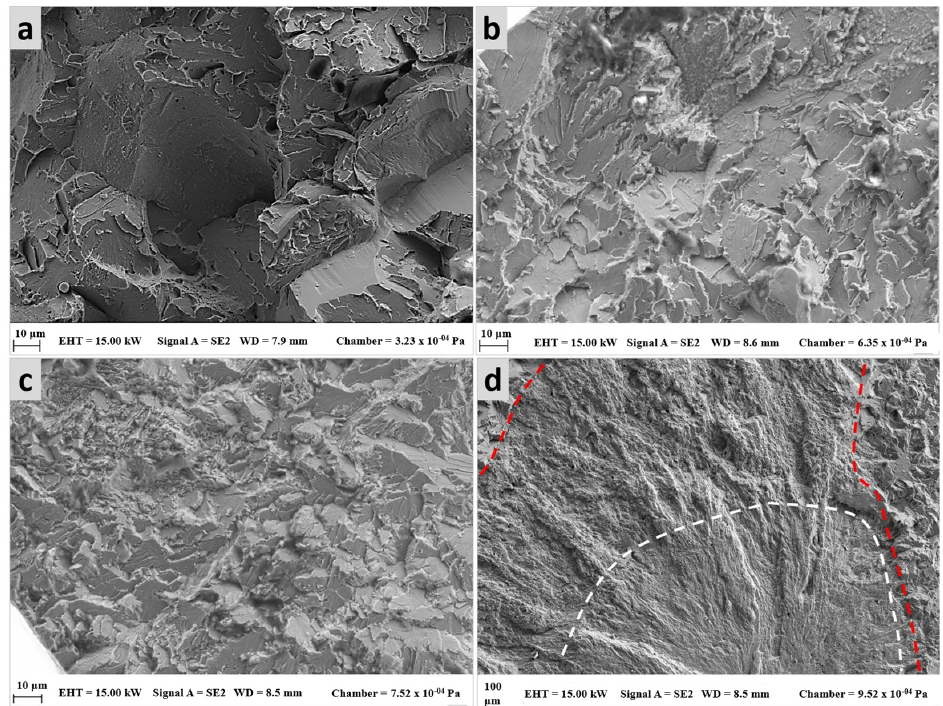
Figure 13. ( a ) Brittle fracture at the core of the material; ( b ) nitriding case nearby final failure with brittle fracture; ( c ) nitriding nearby fatigue nucleation with brittle transgranular fracture; ( d ) fatigue propagation in the fish-eye zone (white line) and crash breaks in the heart zone (red left margin) and nitrided zone (red right margin).